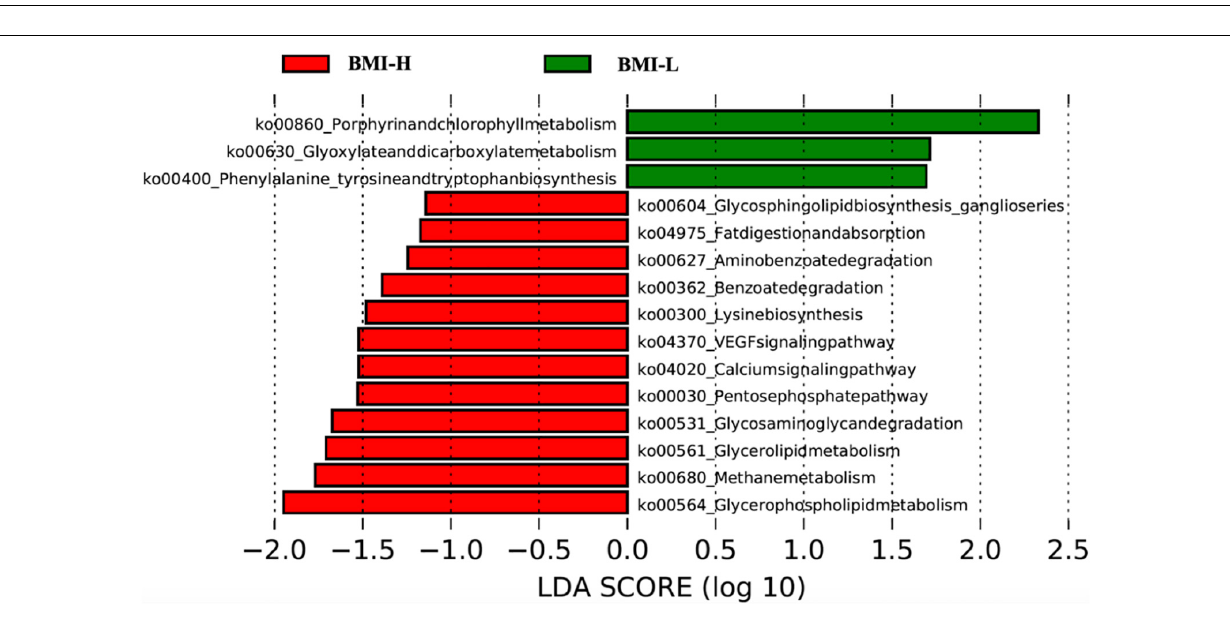
FIGURE 3 | Differently abundant taxa identified using LEfSe analysis. (A) Visualization of only taxa meeting an LDA threshold > 2. (B) LEfSe Cladogram showed the most differentially abundant taxa between the two groups. Taxa enriched for body mass index above 25 kg/m 2 in red and below 25 kg/m 2 in green. The brightness of each dot was proportional to its effect size.